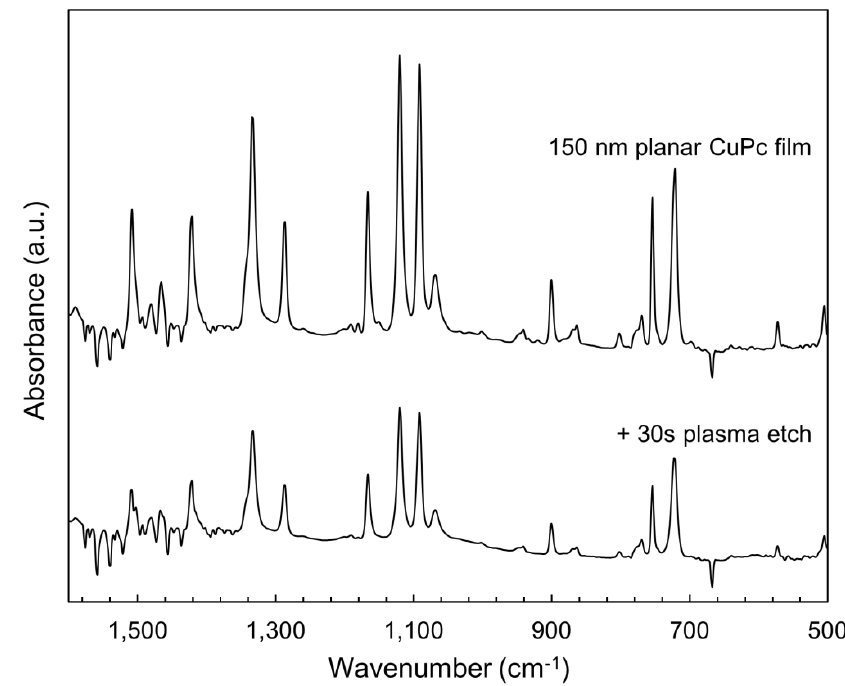
Figure 8. Changes to FTIR absorbance spectra of a CuPc thin film due to 220 W argon plasma etching.